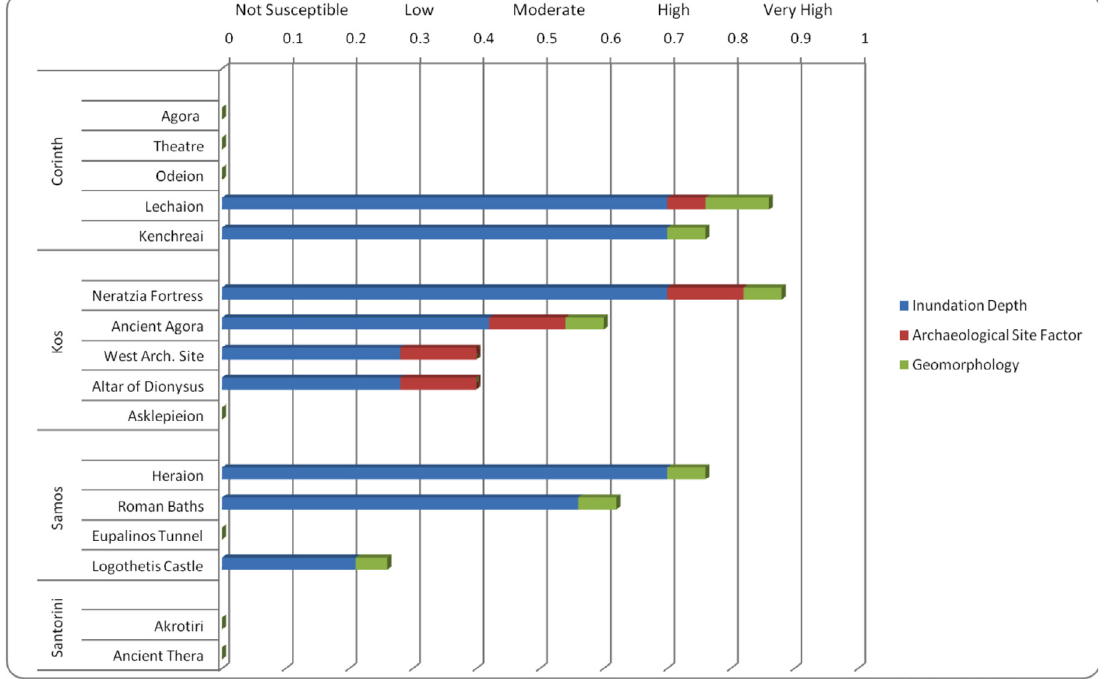
Figure 6. The Tsunami Susceptibility indicator diagram for the archaeological sites under